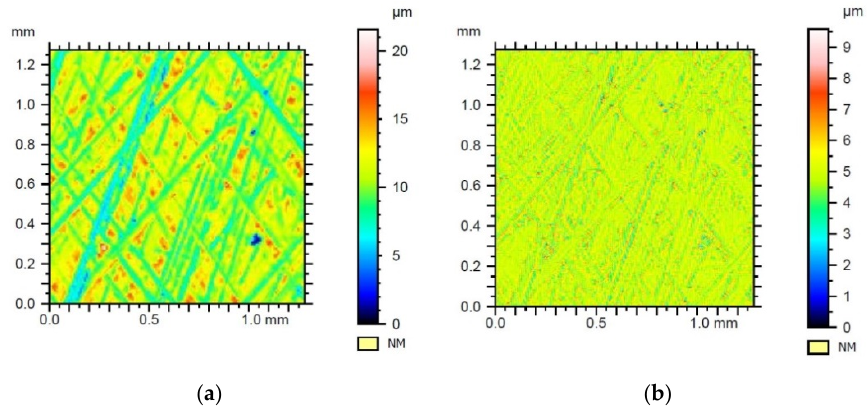
Figure 6. Results of filtration of the surface geometrical structure of sample 1 with Daubechies wavelet on the 1st row with the 1st level of filtration—( a ) waviness, ( b ) roughness.